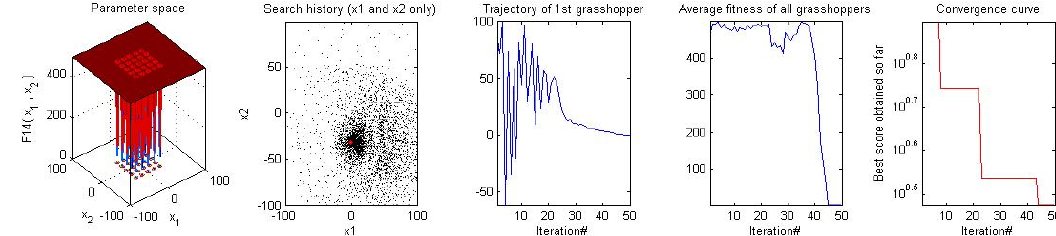
Figure 15. HAGOA behavior on multimodal function (F14)